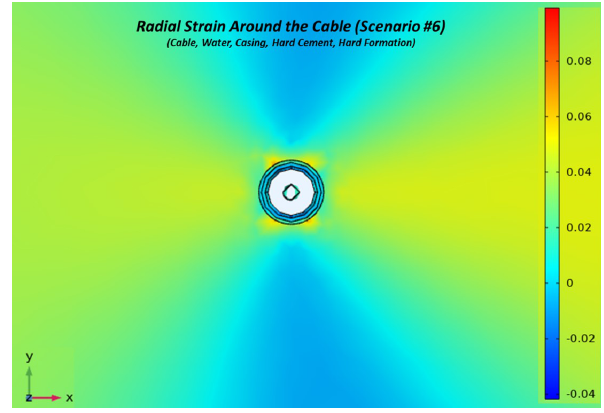
Figure 7. Radial strain around the cable as a response of compres- sional wave propagation at a 90 ◦ incident angle in scenario 3 (inci- dent waveform is incoming from the right).